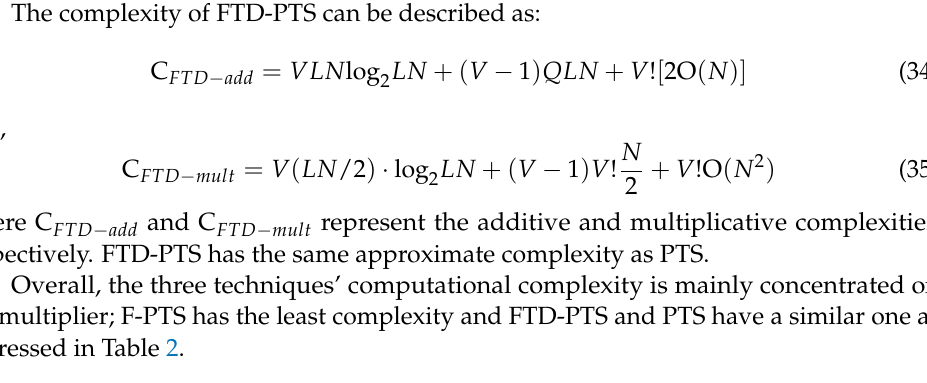
Table 2. The computational complexity of multiple PTS